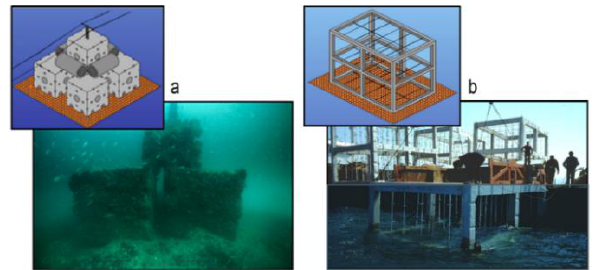
Figure 2. Two-layer pyramids of concrete blocks (a) and concrete cages for mussel culture (b)